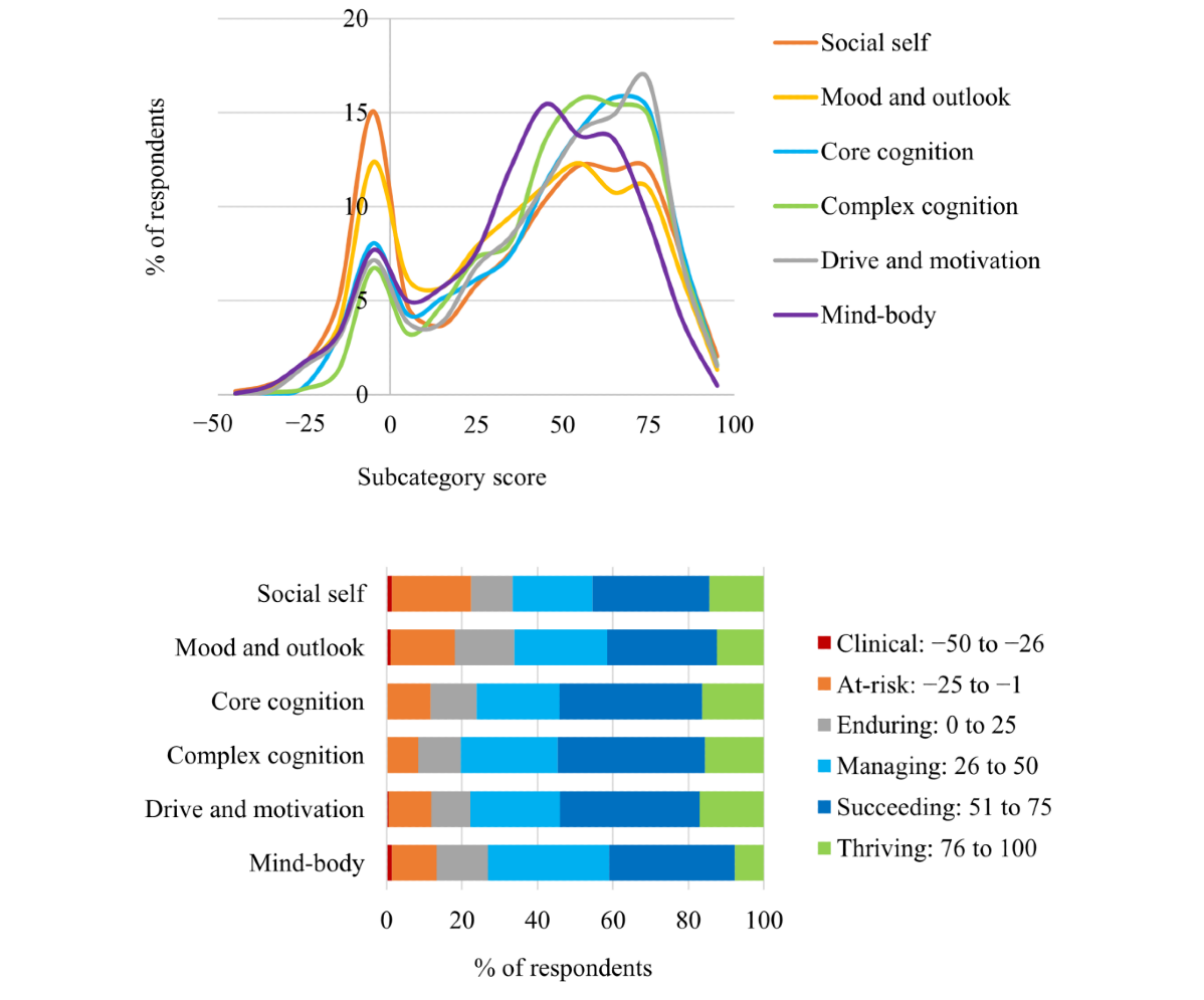
Figure 8. The distribution of Mental Health Quotient subscores for each of the 6 subcategories of mental health and the percentage of respondents for each of the 6 subcategories of mental health for each Mental Health Quotient score level. These levels are (from left to right) clinical, at-risk, enduring, managing, succeeding, and thriving. Numbers in the legend denote the Mental Health Quotient score range for each